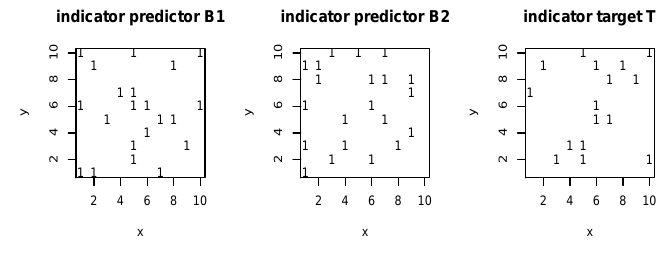
and B , and conditional contingency tables 1 2